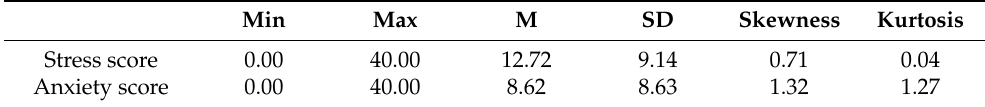
Table 6. The normality of anxiety and stress scores.